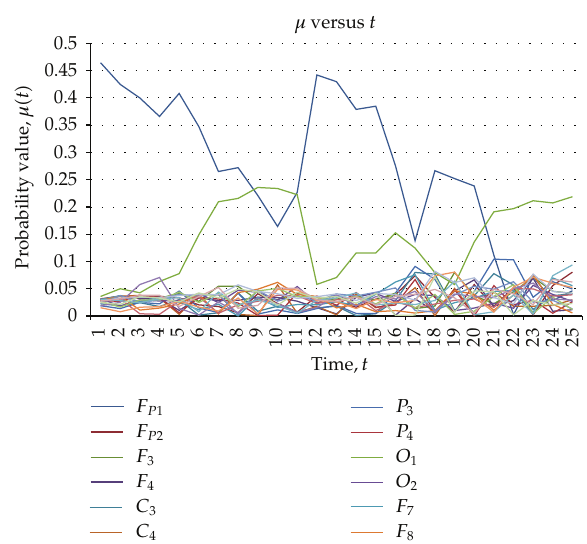
Figure 7: Plot of measure values over time for a 25-second seizure observed in Patient